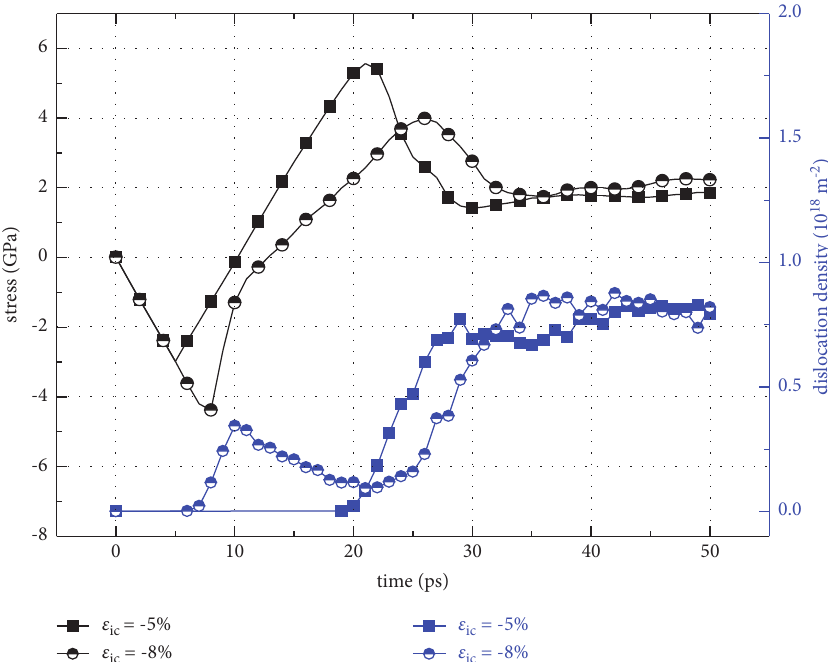
� − 7%, (b) ε � − 7 . 5%, and (c) ε � − 8%. ic ic ic